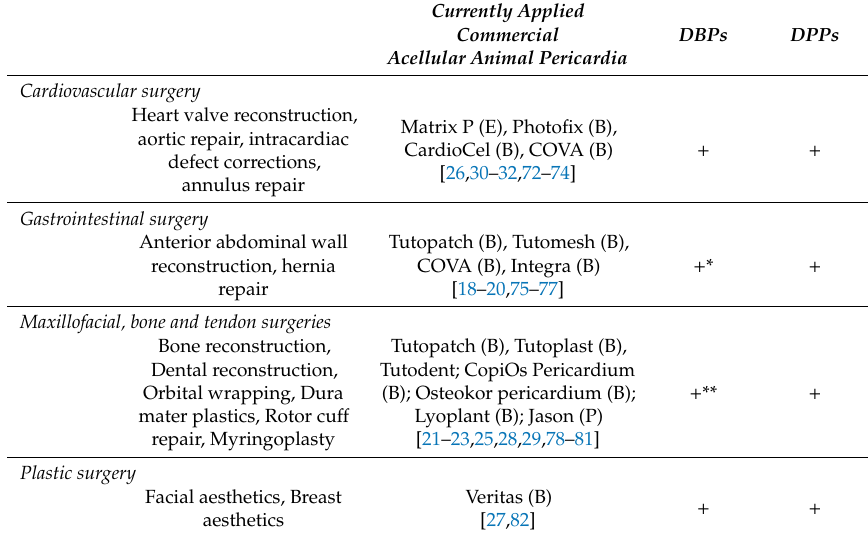
Table 2. Possible Indications for Clinical Applications of TRICOL Decellularized Bovine and Porcine